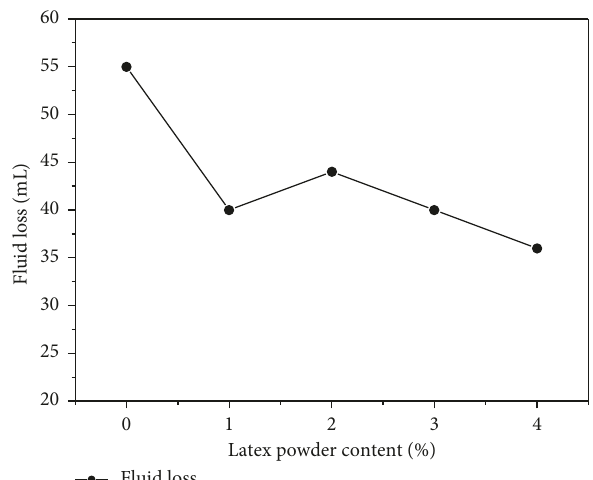
Figure 2: Dependence of latex powder content on fluid loss of cement slurry.